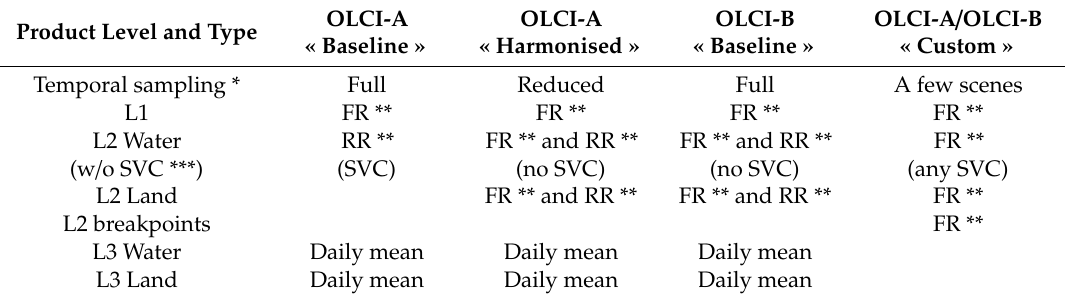
Table 1. Datasets available for all categories of calibration setups: temporal sampling, product levels and